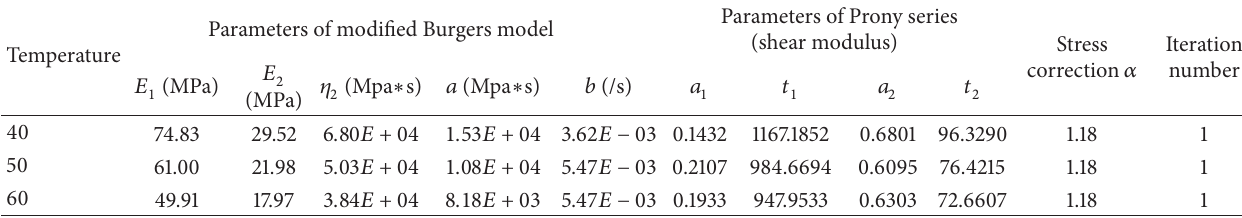
Table 5: Experimental data fitting results after stress